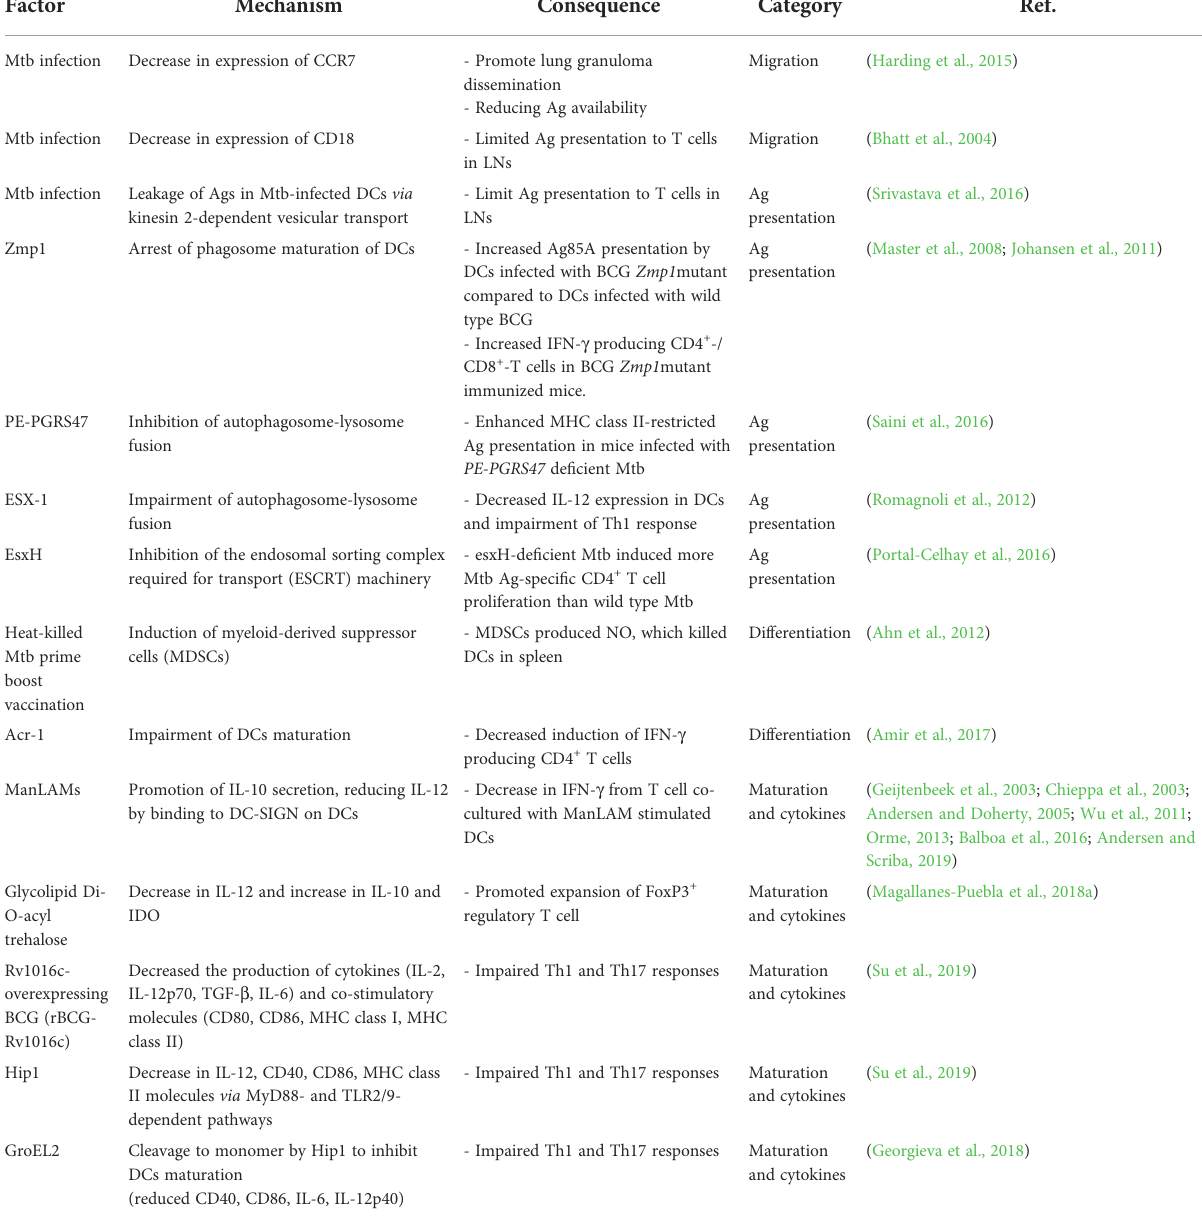
TABLE 1 Mtb and its components that inhibit DC